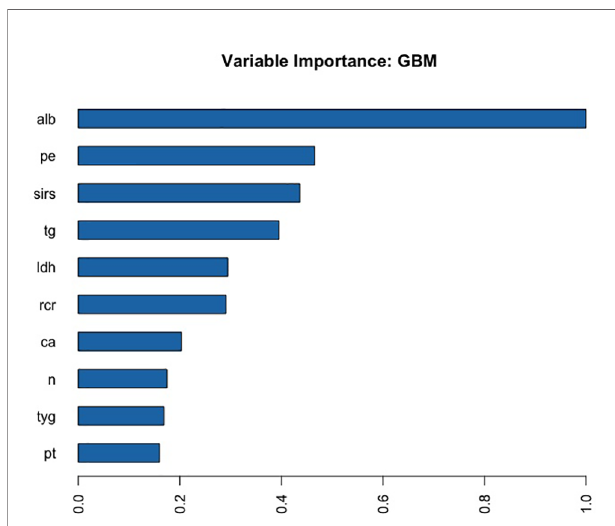
FIGURE 3 | Variable importance of the GBM model in the training set, showing that albumin was the most important feature, followed by PE, SIRS, TGs, LDH, etc. ALB, albumin; PE, pleural effusion; SIRS, systemic in fl ammatory response syndrome; TG, triglyceride; LDH, lactic